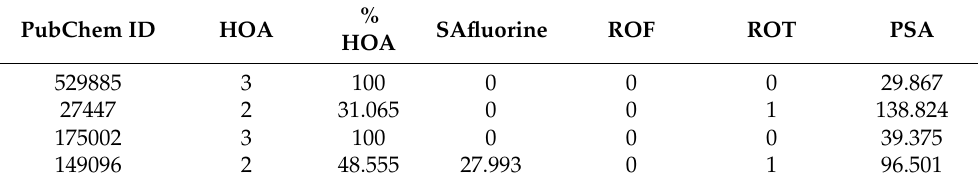
Table 2. Bio-absorbability output of test compounds.